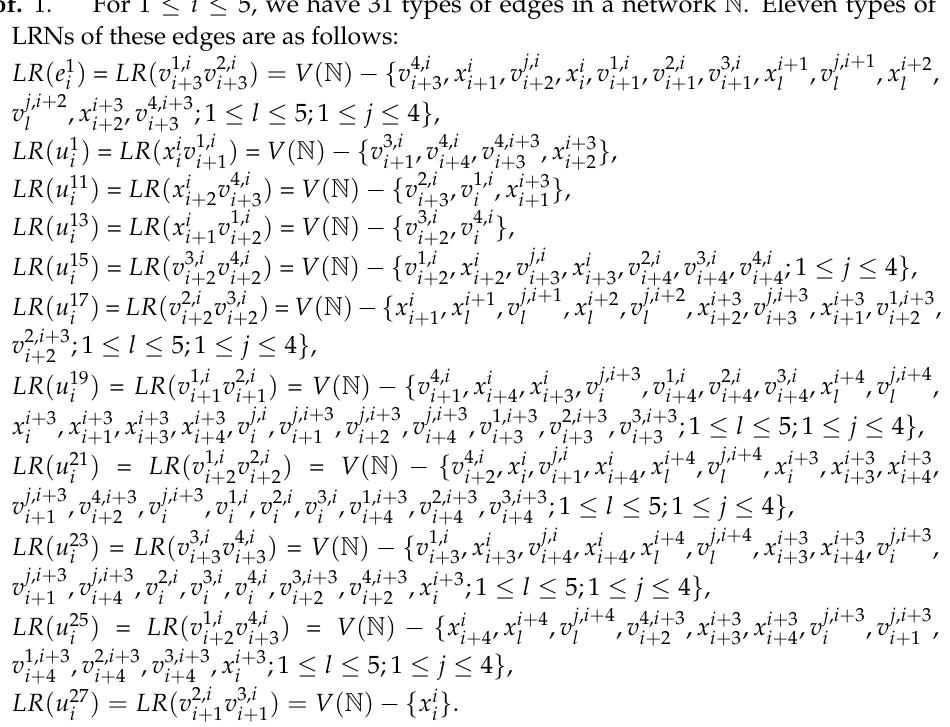
Table 2. Local resolving neighborhood set (LRNs) LR ( e y